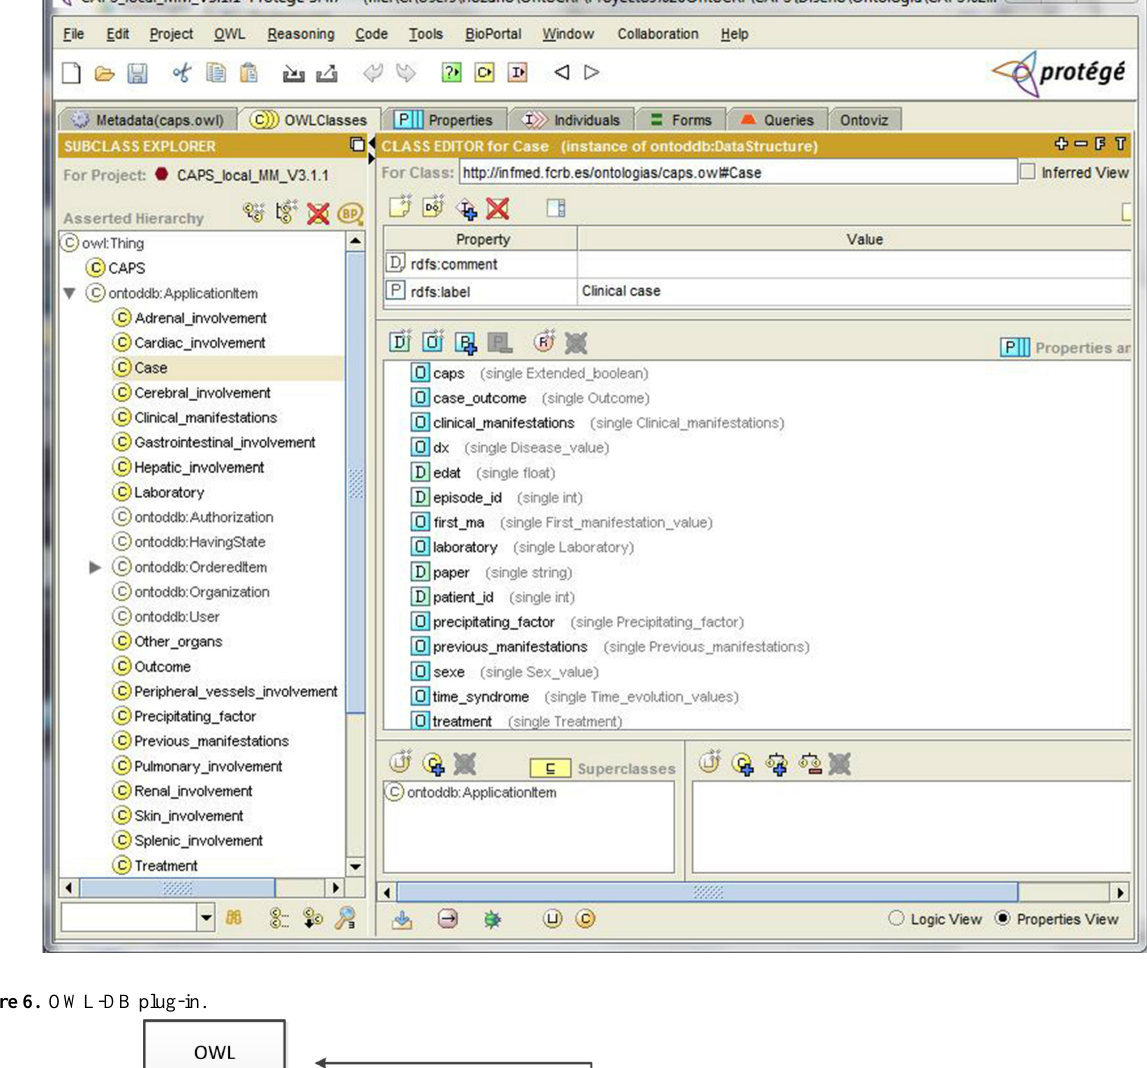
Figure 5. Ontology edition with Protégé.